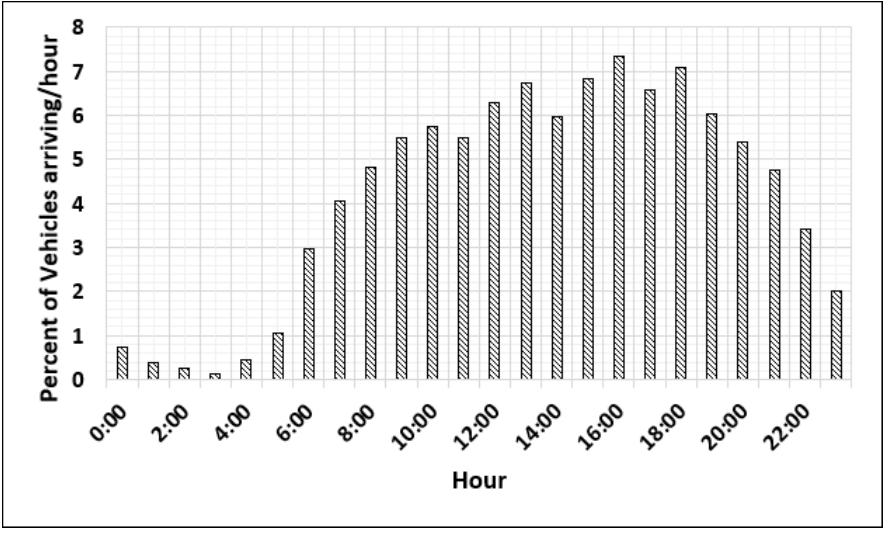
Figure 4. Percentage of BPEVs arriving per hour at the fast charging station (arrival rate) [28].